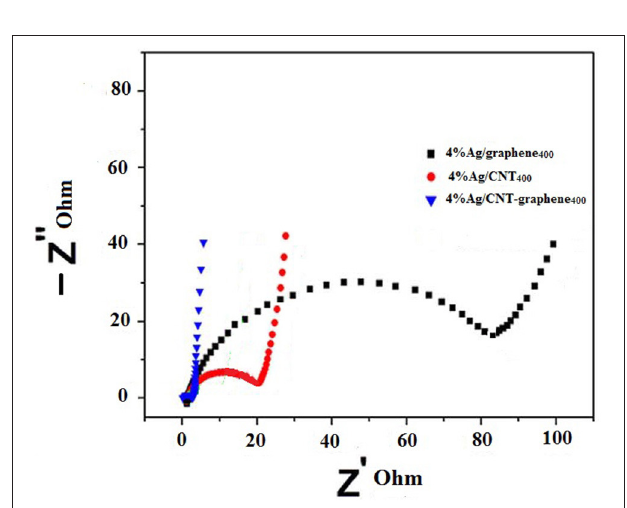
FIGURE 12 | Electrochemical impedance spectra (EIS) of 4%Ag/graphene 400 , 4%Ag/CNT 400 and 4%Ag/CNT-graphene 400 electrodes at room temperature in 6.0M